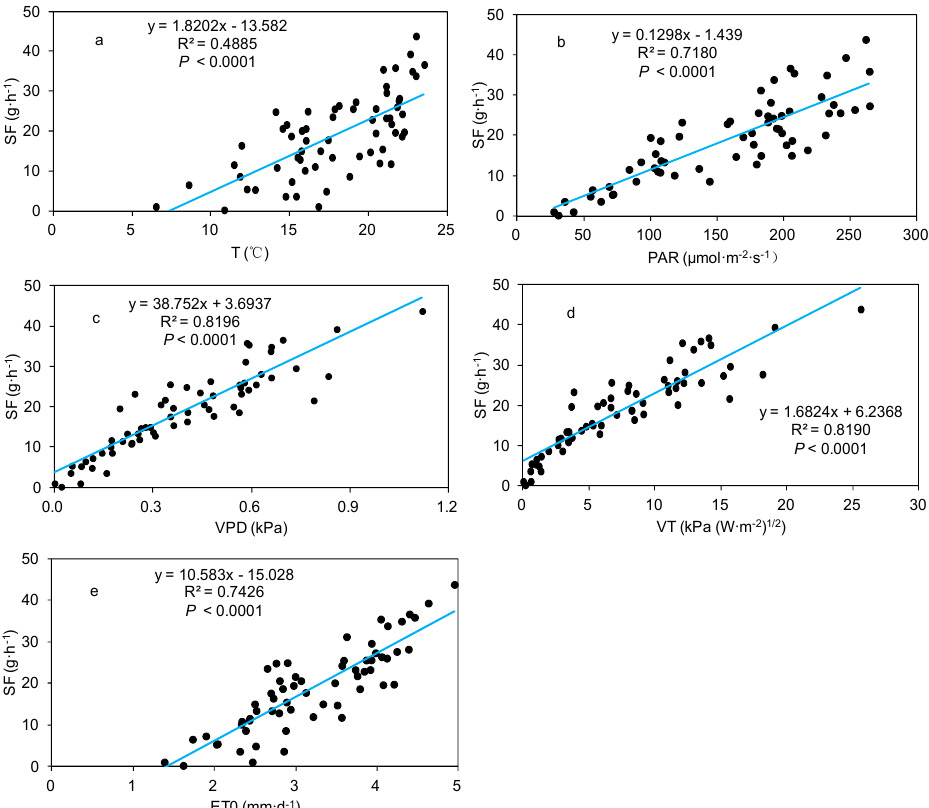
Figure 5. Regression relations between daily SF and ( a ) air temperature (T), ( b ) photosynthetically active radiation (PAR), ( c ) vapor pressure deficit (VPD), ( d ) variable of transpiration (VT), and ( e ) reference evapotranspiration (ET 0 ).